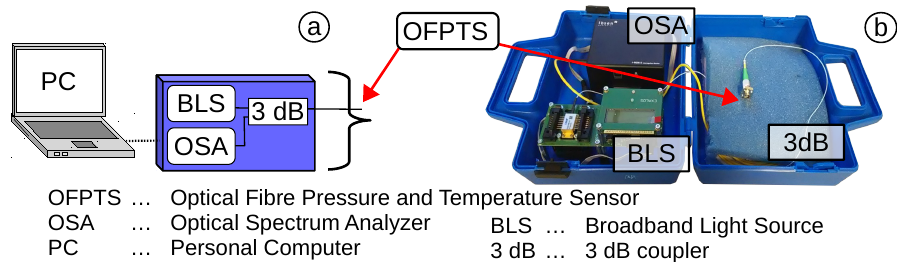
Figure 1. ( a ) Schematic of the optical fibre pressure and temperature sensors (OFPTS) system; ( b ) the hand-case-sized optical fibre